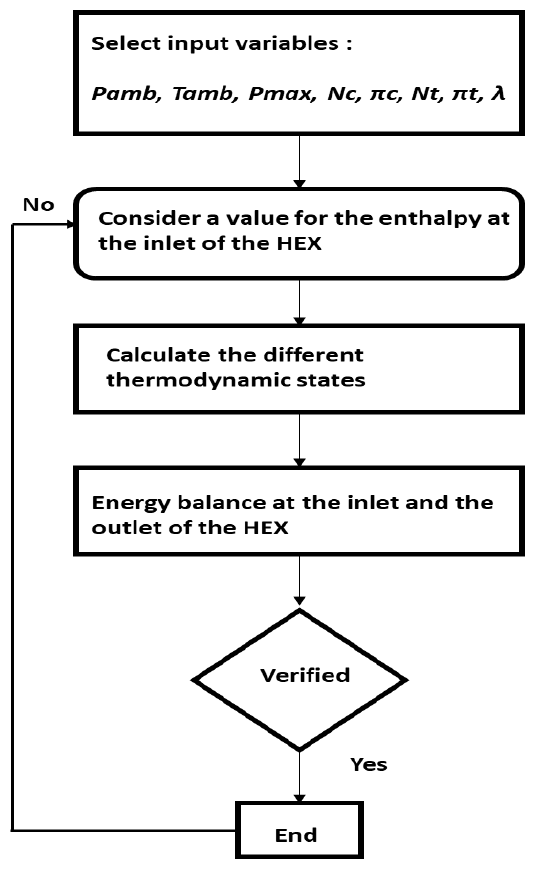
Figure 8. Methodology for the thermodynamic analysis.